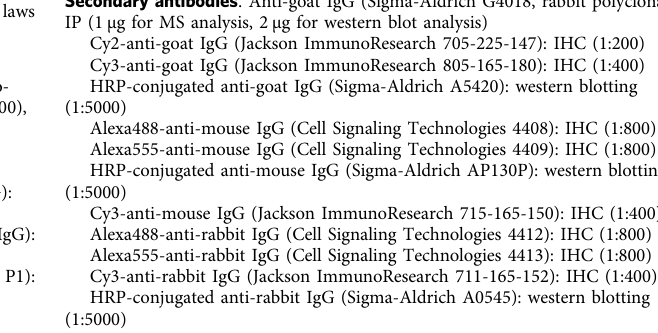
Western blotting: one strong signal at ~180kDa for nuclear brain lysate, but not for mESC TET TKO cells (Supplementary Fig. 3a) ● ICC: no signal in mESC TET TKO (Supplementary Fig. 3c) ● IP: validation for IP has already been reported 43